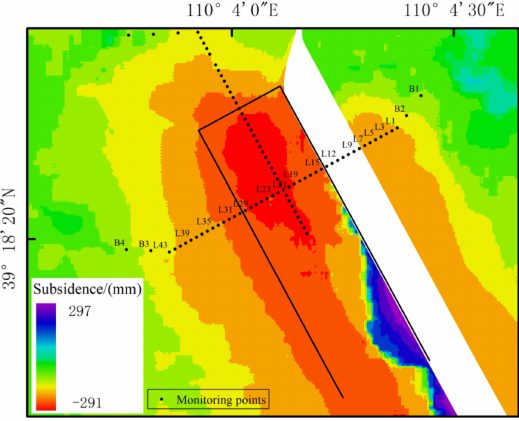
Figure 14. Subsidence calculated by InSAR combined with depression angle model.